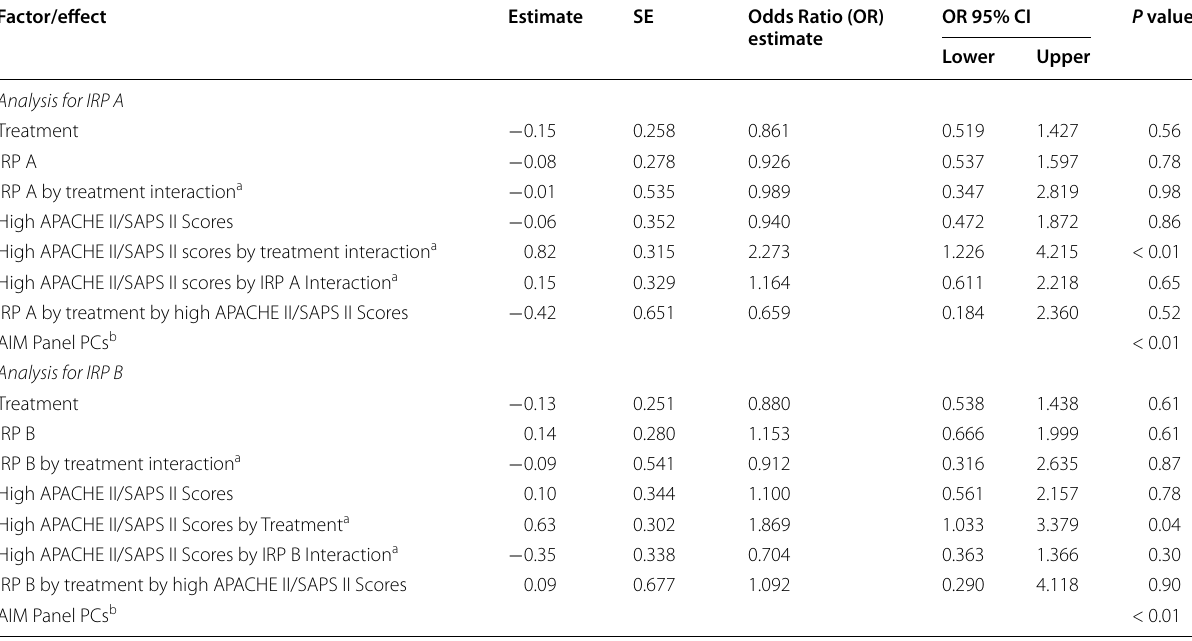
Table 4 Secondary analyses for effects of high APACHE II/SAPS II scores on differential treatment effects of IRP A and IRP B on mortality—conditional logistic regression models including AIM panel